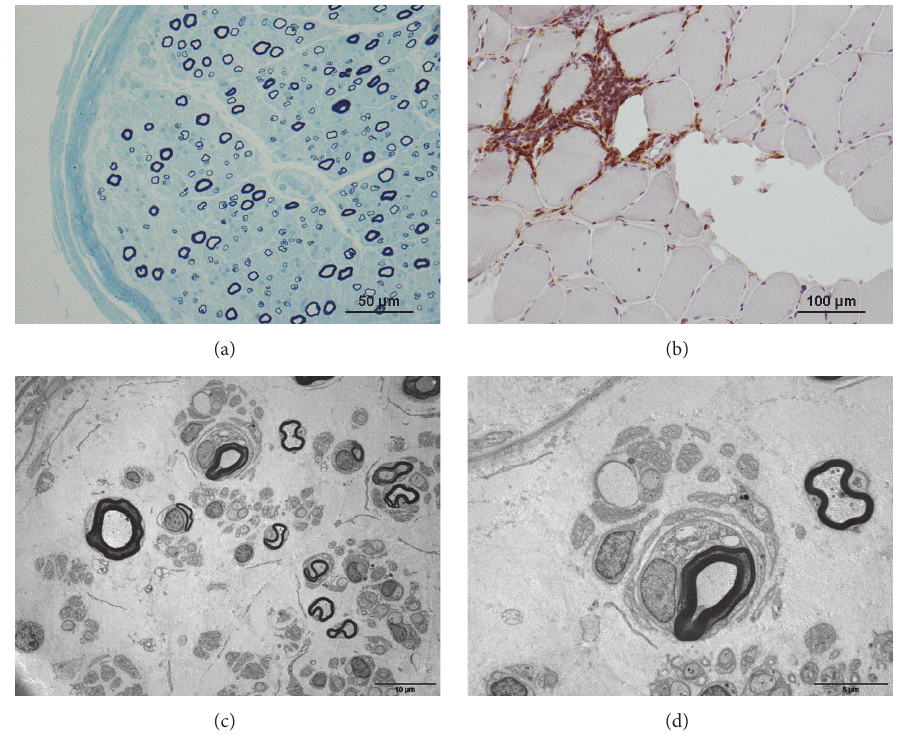
Figure 2: Pathological findings in patient 2. (a) Transverse semithin section of a sural nerve stained with Toluidine Blue: there is a moderate loss of myelinated fibers; several fibers have a too thin sheath compared to their axonal diameter. (b) Frozen section of a deltoid muscle stained with anti-CD45 antibody showing the presence of T cell infiltrates. (c) Electron micrograph of a sural nerve section showing a myelinated fiber which is surrounded by an onion bulb formation. (d) Same field as in (c) but at higher